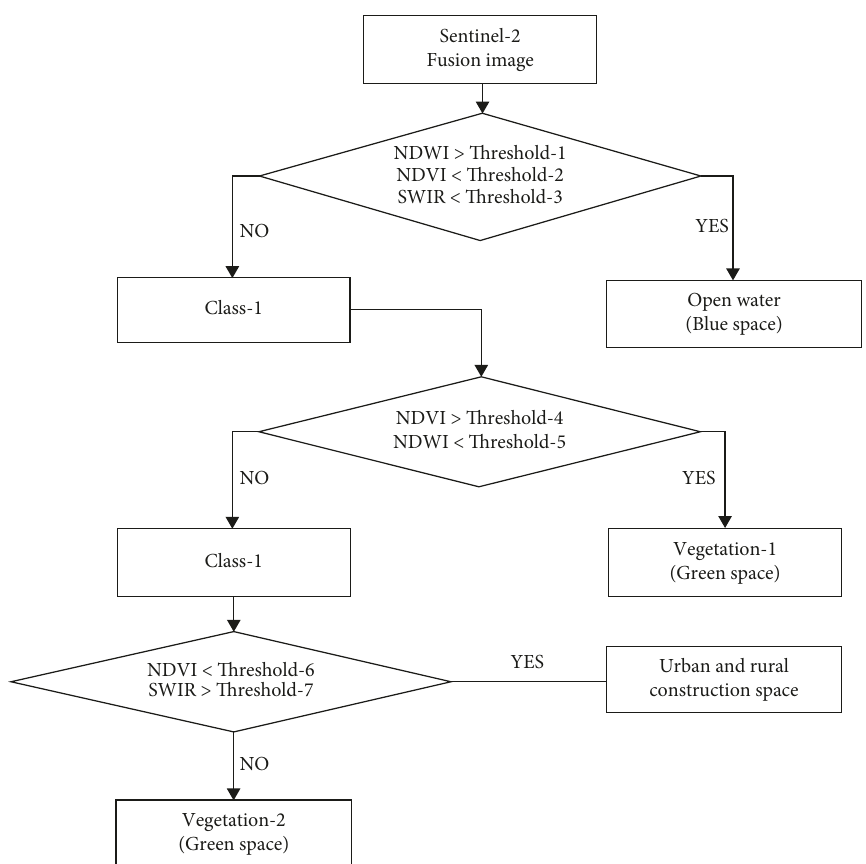
Figure 2: BGS information extraction model for Baiyangdian